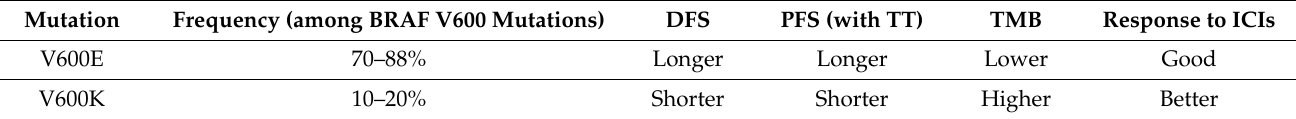
Table 1. Different clinicopathological characteristics between BRAF V600E- and V600K-mutant melanoma patients. Mutation Frequency (among BRAF V600 Mutations) DFS PFS (with TT) TMB Response to ICIs V600E 70–88% Longer Longer Lower Good V600K 10–20% Shorter Shorter Higher